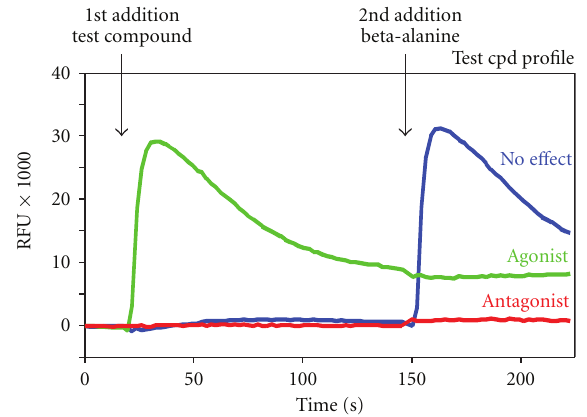
Figure 3: Assay format for the identification of an agonist and antagonist from a single screen. Test compound is added first followed by a second addition of beta-alanine. An agonist will induce a FLIPR response immediately upon the addition of a test compound. An antagonist will cause a pharmacological blockade of the MrgD receptor resulting in attenuation or complete lack of response to beta-alanine. In the event of no receptor engagement, a normal agonist response will be observed from beta-alanine addition.